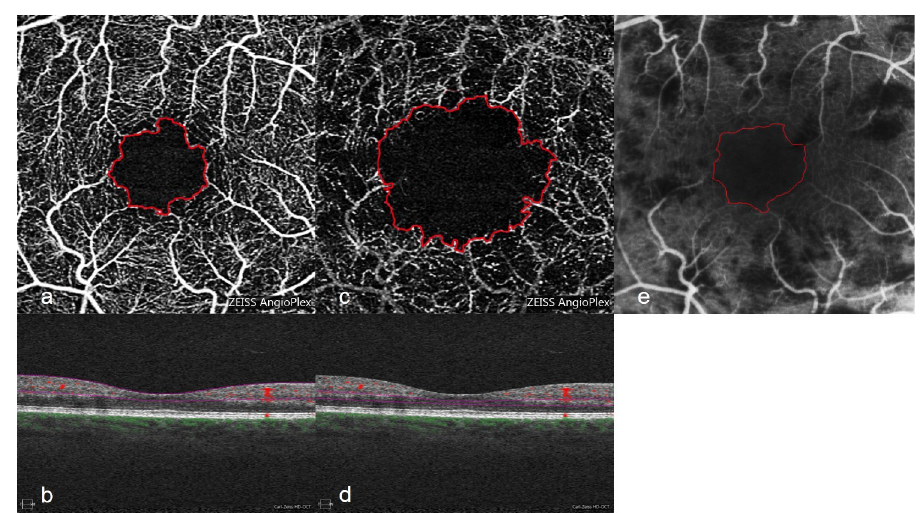
Fig 2. Prepared OCTA and FA images for evaluation of FAZ. Same patient as shown in Fig 1. OCTA SCL with red bordered FAZ (a). Segmentation is displayed below (b). OCTA DCL with red bordered FAZ (c) with corresponding segmentation in (d). FA with red bordered FAZ (e).